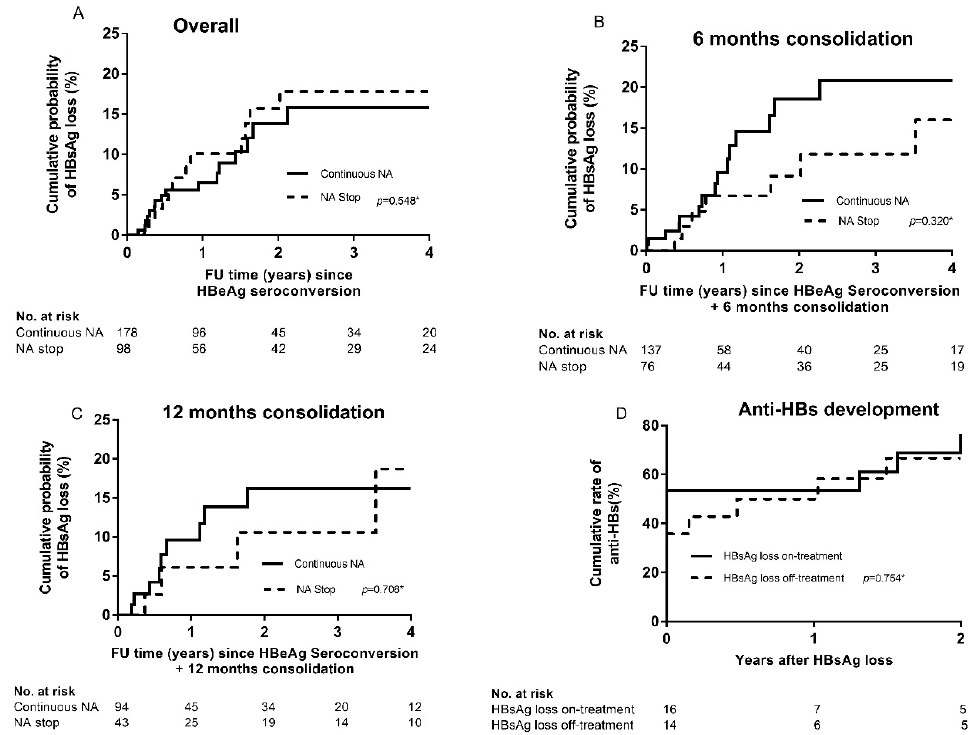
Figure 3. Kaplan–Meier curves showing (1) the cumulative probability of HBsAg loss after HBeAg seroconversion using a clock-reset approach ( A – C ) and (2) the cumulative probability of anti-HBs development after HBsAg loss ( D ). Analysis of ( A ) the entire cohort. Origin of X-axis is set at HBeAg seroconversion. ( B ) Patients with at least six months consolidation treatment. Origin of X-axis is set at six months after HBeAg seroconversion. ( C ) Patients with at least 12 months consolidation treatment. Origin of X-axis is set at 12 months after HBeAg seroconversion and ( D ) all patients with HBsAg loss. As described in the Methods section, patients in the continuous treatment group were censored at the time of HBsAg loss, loss to follow-up or treatment cessation. Patients in the treatment cessation group were censored at the time of HBsAg loss, loss to follow-up or retreatment initiation. Patients were considered continuing treatment until treatment was discontinued and were censored in the group continuing treatment at the time of treatment cessation. The moment of treatment cessation was subsequently considered as time zero for further follow-up in the treatment stop group. * p -value = log-rank, HBeAg: Hepatitis B e antigen, HBsAg: Hepatitis B surface antigen, NA: Nucleos(t)ide Analogues, Anti-HBs: Anti hepatitis B surface antigen antibody. FU: